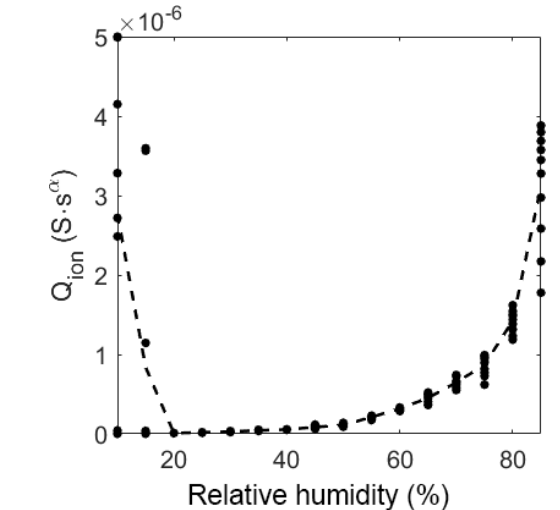
Figure 13. Prefactor of CPE dl over relative humidity at room tem- perature. The dots represent the value of the fit of each measure- ment. The dashed line represents the mean of the